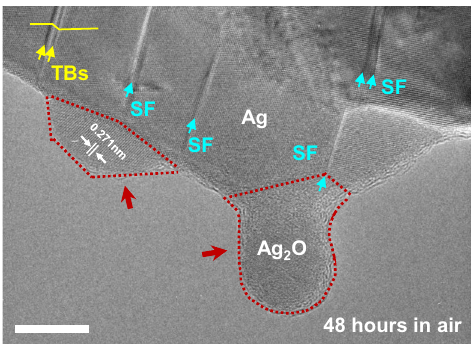
Fig. 5 Natural oxidation of an Ag nanocrystal with multiple planar defects. The Ag nanocrystal was exposed in ambient environment at room temperature for 2 days. The naturally oxidized Ag also exhibits similar site- selective oxidation behaviours along the pre-existing SFs. Scale bar: